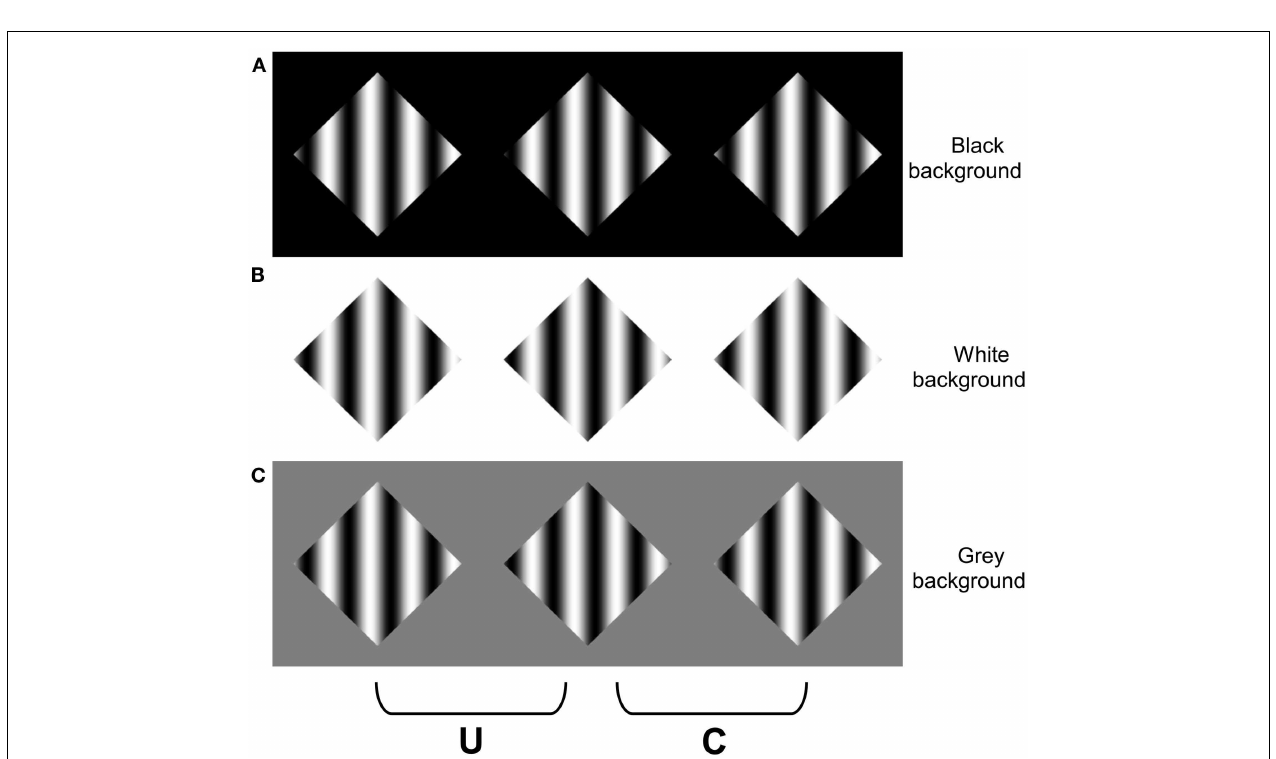
However, when the disparity of the boundary is inverted, the stereograms in (A,B) appear to split into two layers: hazy black bars occluding a white diamond in (A) , and hazy white bars occluding a black diamond in (B) . No coherent percept of scission is experienced within the grating for the gray background in (C) . Note that the perception of occlusion and transparency in (A,B) arise from a combination of segmentation processes that split the grating into two components, and integration processes that amodally integrate the disparities along the diamond boundary into a coherent surface. Adapted from Anderson (1999), with